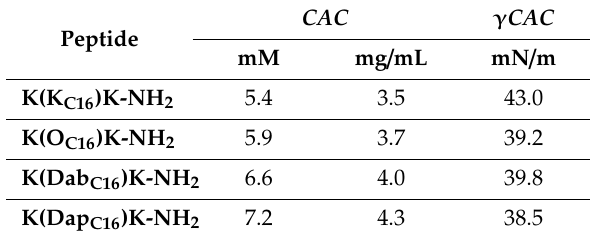
Table 3. Critical aggregation concentration ( CAC ) and surface tension at the CAC point.